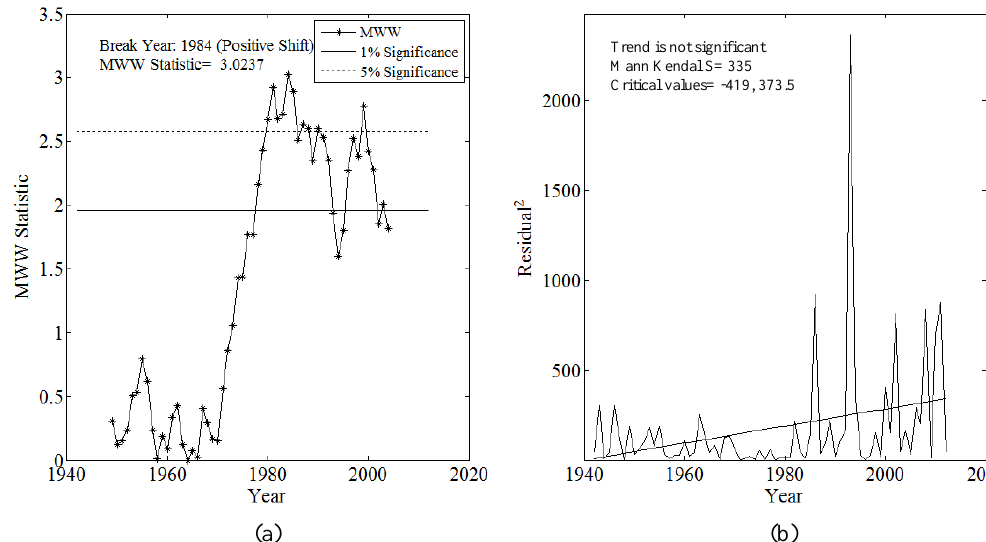
Figure 4. MWW (a) and MK (b) test results for variance of annual maximum rainfall for Station no.